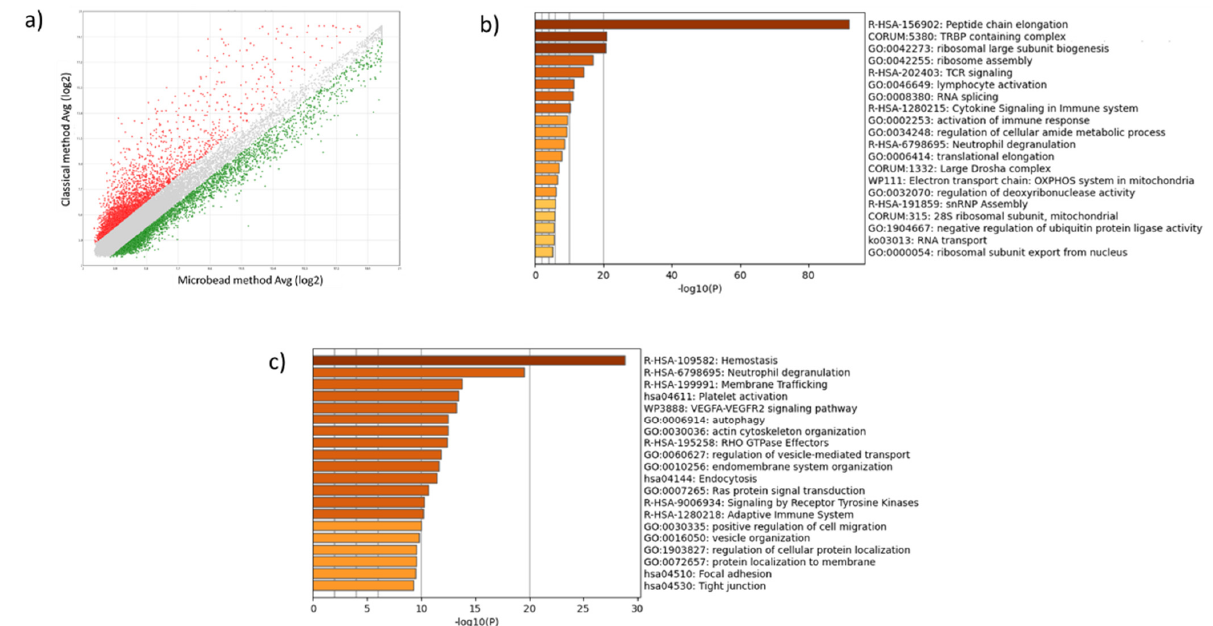
Figure 2. Differential presence of transcripts in platelets purified with or without microbeads. ( a ) Scatter plot showing the distribution of transcripts according to their relative level, presented as average log2 (RNA level). Gray dots indicate transcripts present at the same level in compared samples. Red dots indicate transcripts increased in platelets purified with classical method compared to those purified with microbeads, while green dots indicate decreased transcripts. ( b , c ) Metascape bar graph showing top enriched ontolog clusters in the lists of transcripts with increased and decreased relative amount ( b and c , respectively) in platelets purified without microbeads.